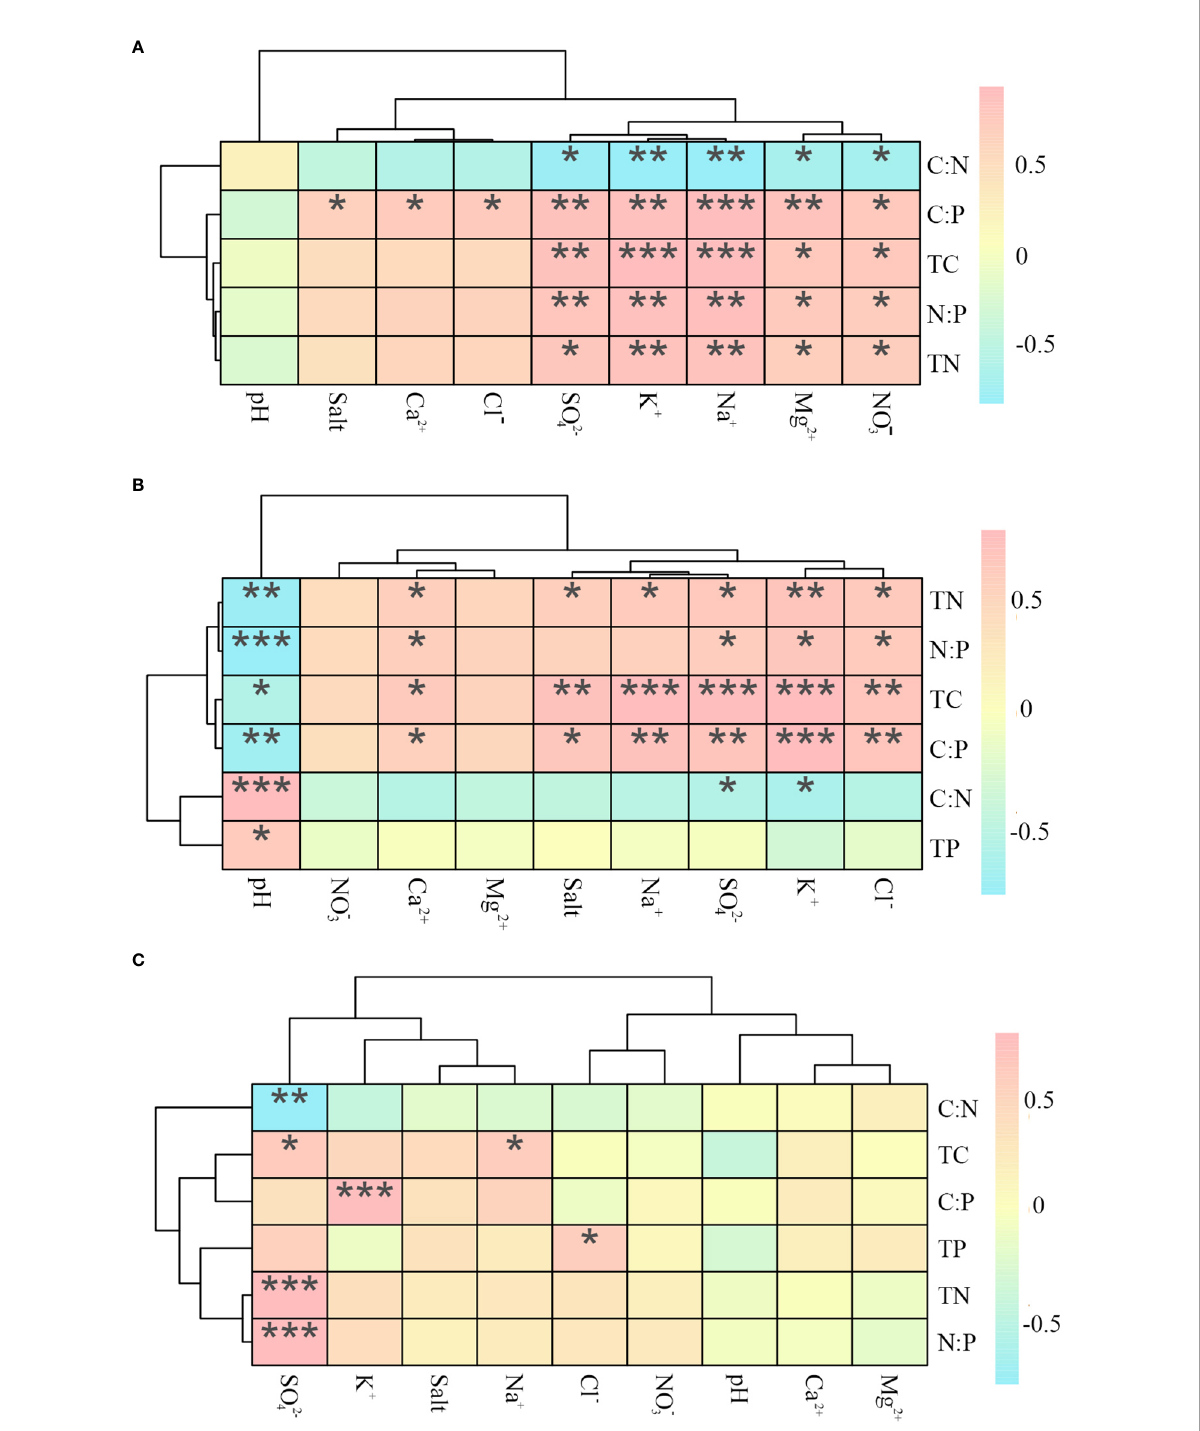
FIGURE 8 Heat map of correlations between ecological stoichiometry and ions in P. communis (A) , S. salsa (B) and A. sinensis (C) . *, ** and *** represent signi fi cant differences at 0.05, 0.01 and 0.001 levels